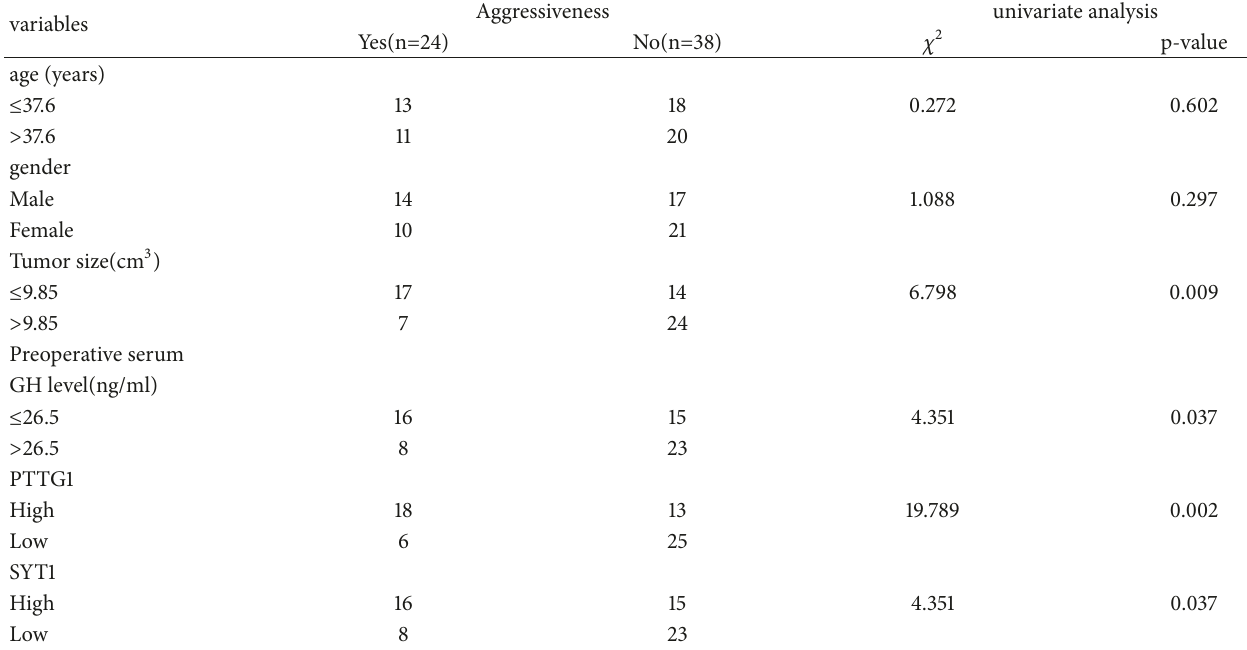
Table 2: Univariate and multivariate analyses for the clinicopathological